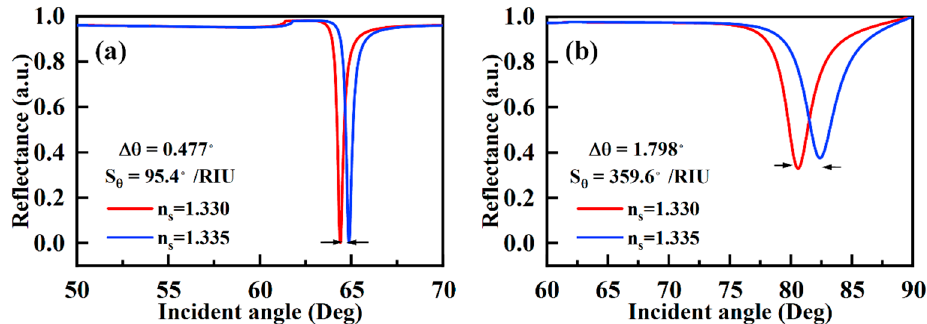
Figure 2. Reflectance variation under different incident angle for ( a ) SPR sensor with 40 nm Al film, ( b ) SPR sensor with the bimetallic layer of 40 nm Al and 22 nm Ni.